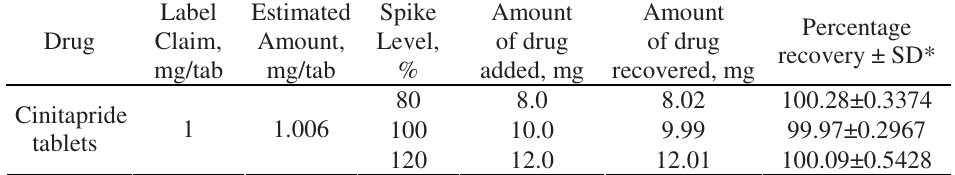
Table 3 . Recovery